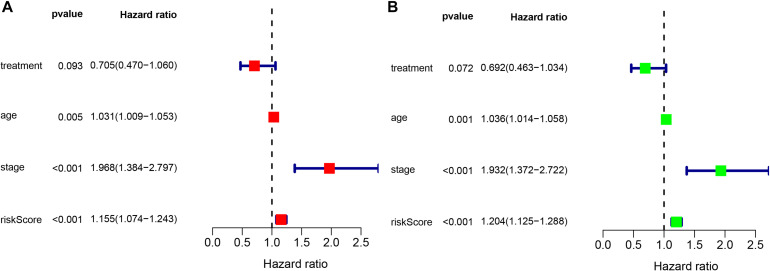
Univariate and multivariate Cox analyses evaluating the independent predictive ability of our signature for OS. (A) Univariate Cox analyses and (B) multivariate Cox analyses.